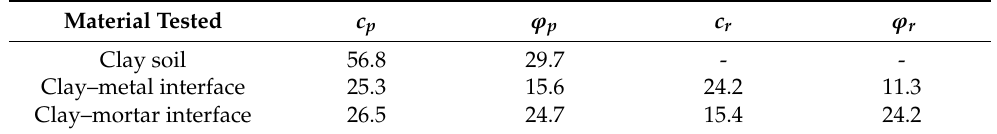
Table 3. Strength parameters of clay and clay–structure